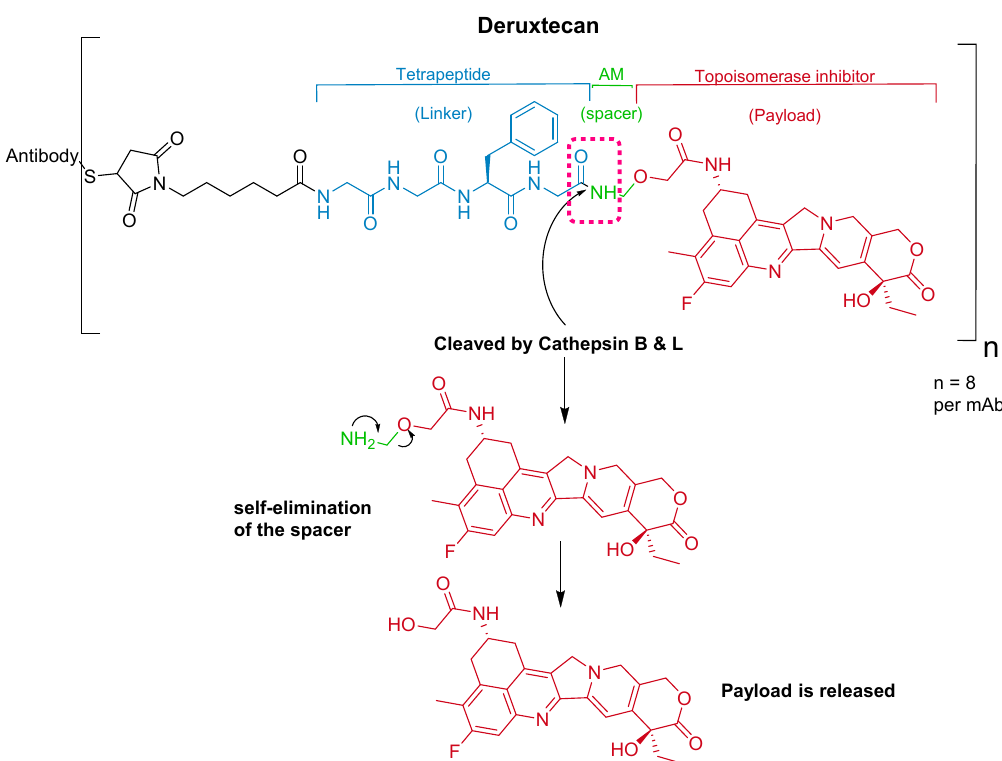
Figure 10. Chemical structure of fam-trastuzumab deruxtecan-nxki (Enhertu TM ) showing the tetrapeptide linker and amino methylene cleavage in the payload-release process. AM; aminomethyl